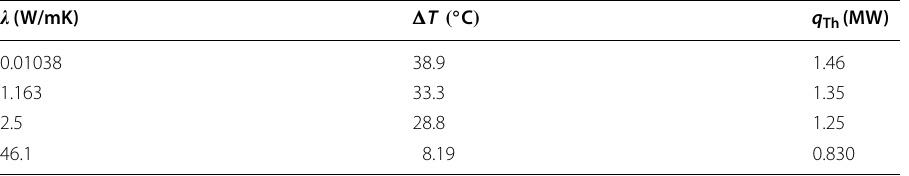
Table 8 Key thermodynamic properties for various (cid:31) (W/mK) quoted to 3.s.f (cid:31)